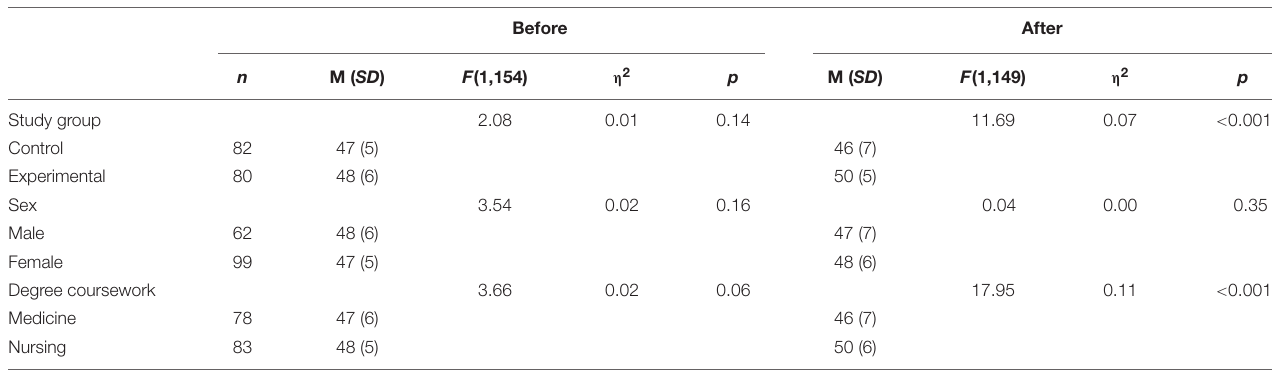
TABLE 2 | Descriptive statistics and analysis of variance (Three-way ANOVA) of the scores of the inter-professional collaborative work by study group, gender, and degree coursework ( n =